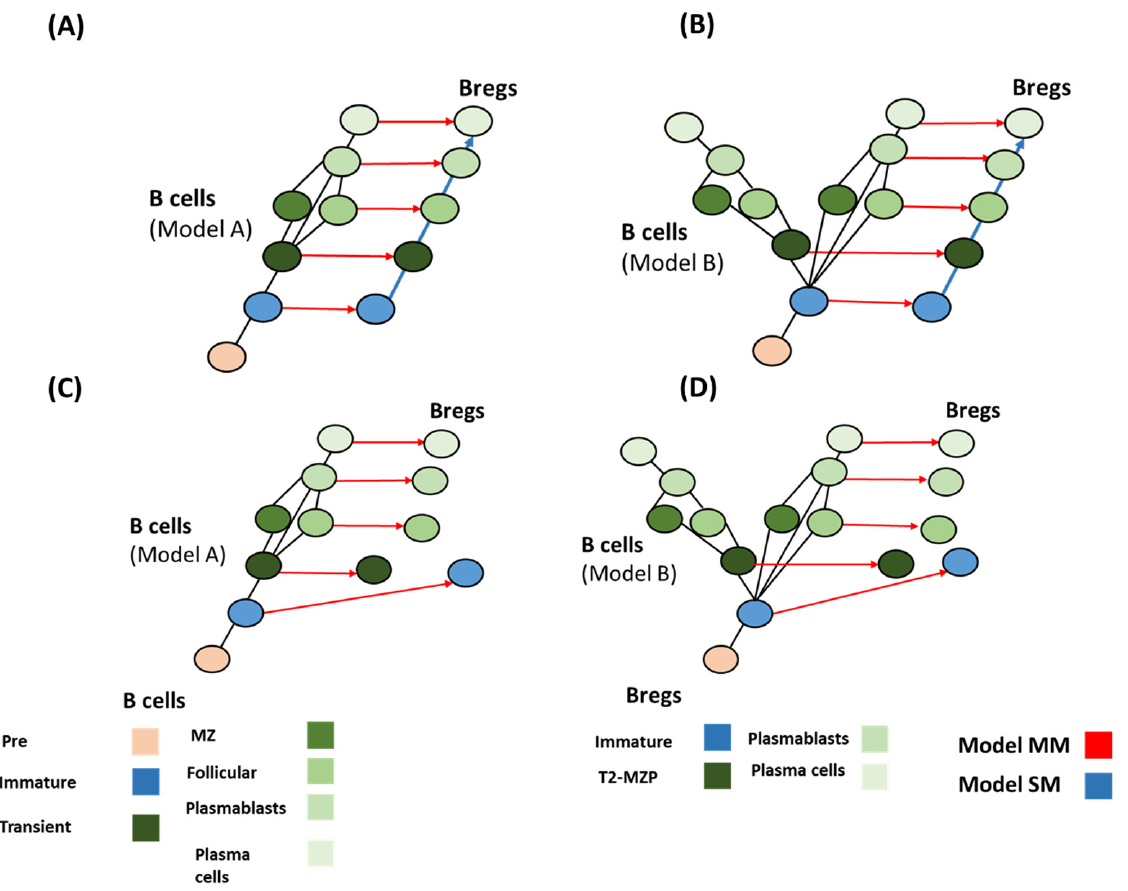
Figure 7. Possible mechanisms of Breg emergence. ( A , B ) Model MM and model SM best fit the data for both evolutionary models of B cells (model A and model B), in the case of immature Bregs being found in fish. Conversely ( C , D ), in the case that immature Bregs are missing in fish, model MM and SS best fit the data. These different combinations do not reveal the origin of B10 and Tim1. Table 3. Feasibility of Breg models based on known evolutionary patterns.